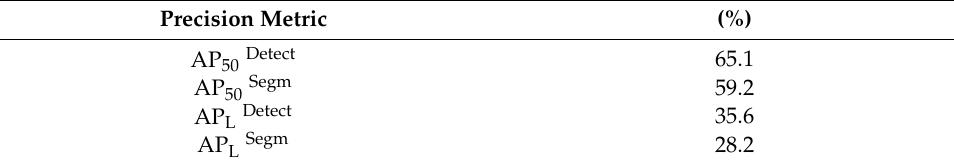
Table 8. Precision metrics values for the test dataset.